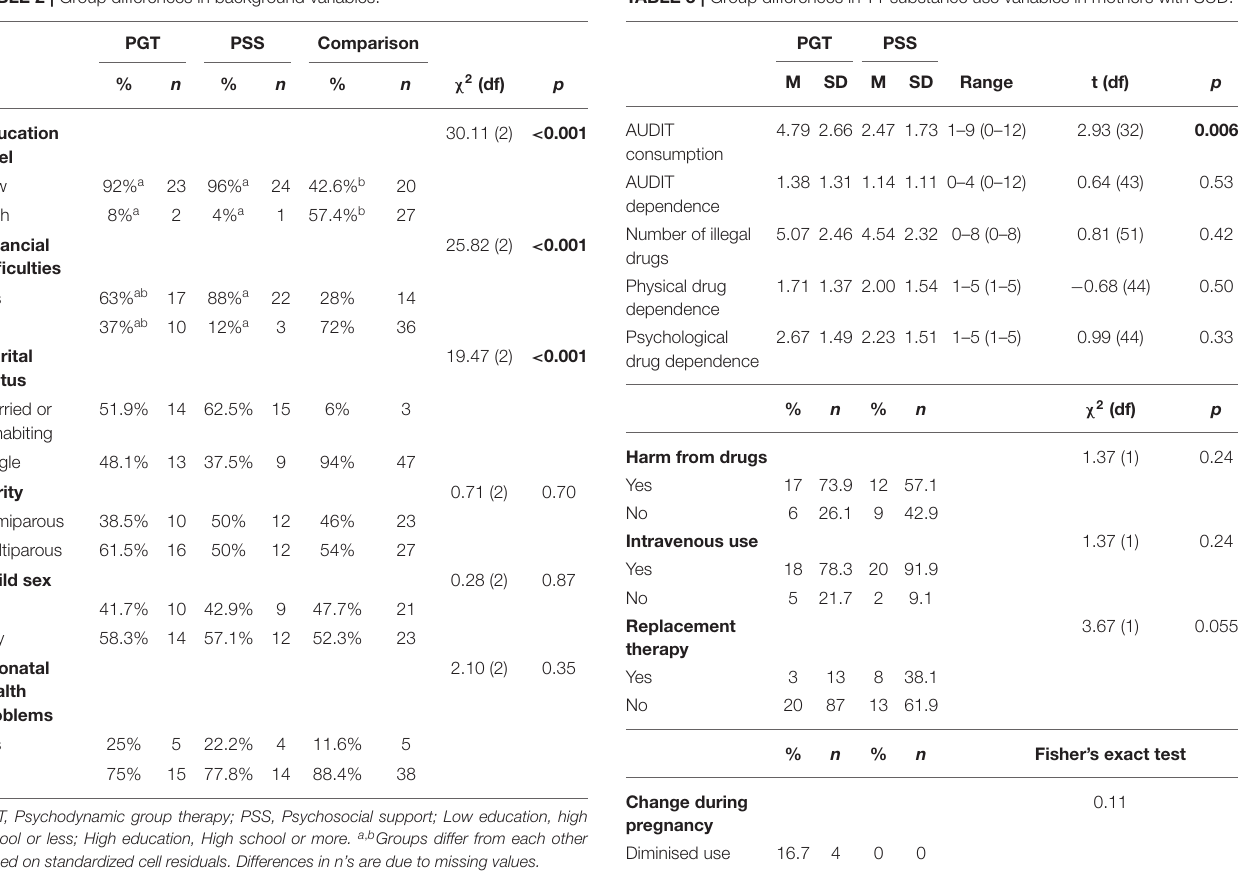
TABLE 2 | Group differences in background variables. TABLE 3 | Group differences in T1 substance use variables in mothers with